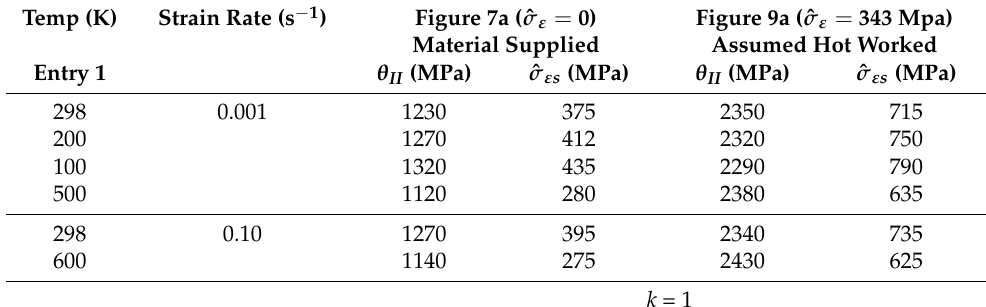
Table 4. Saturation threshold stress and θ II for the six stress–strain curves in Figure 5. Temp (K) Strain Rate (s − 1 ) Figure 7a ( ˆ σ ε = 0) Figure 9a ( ˆ σ ε = 343 Mpa) Material Supplied Assumed Hot Worked